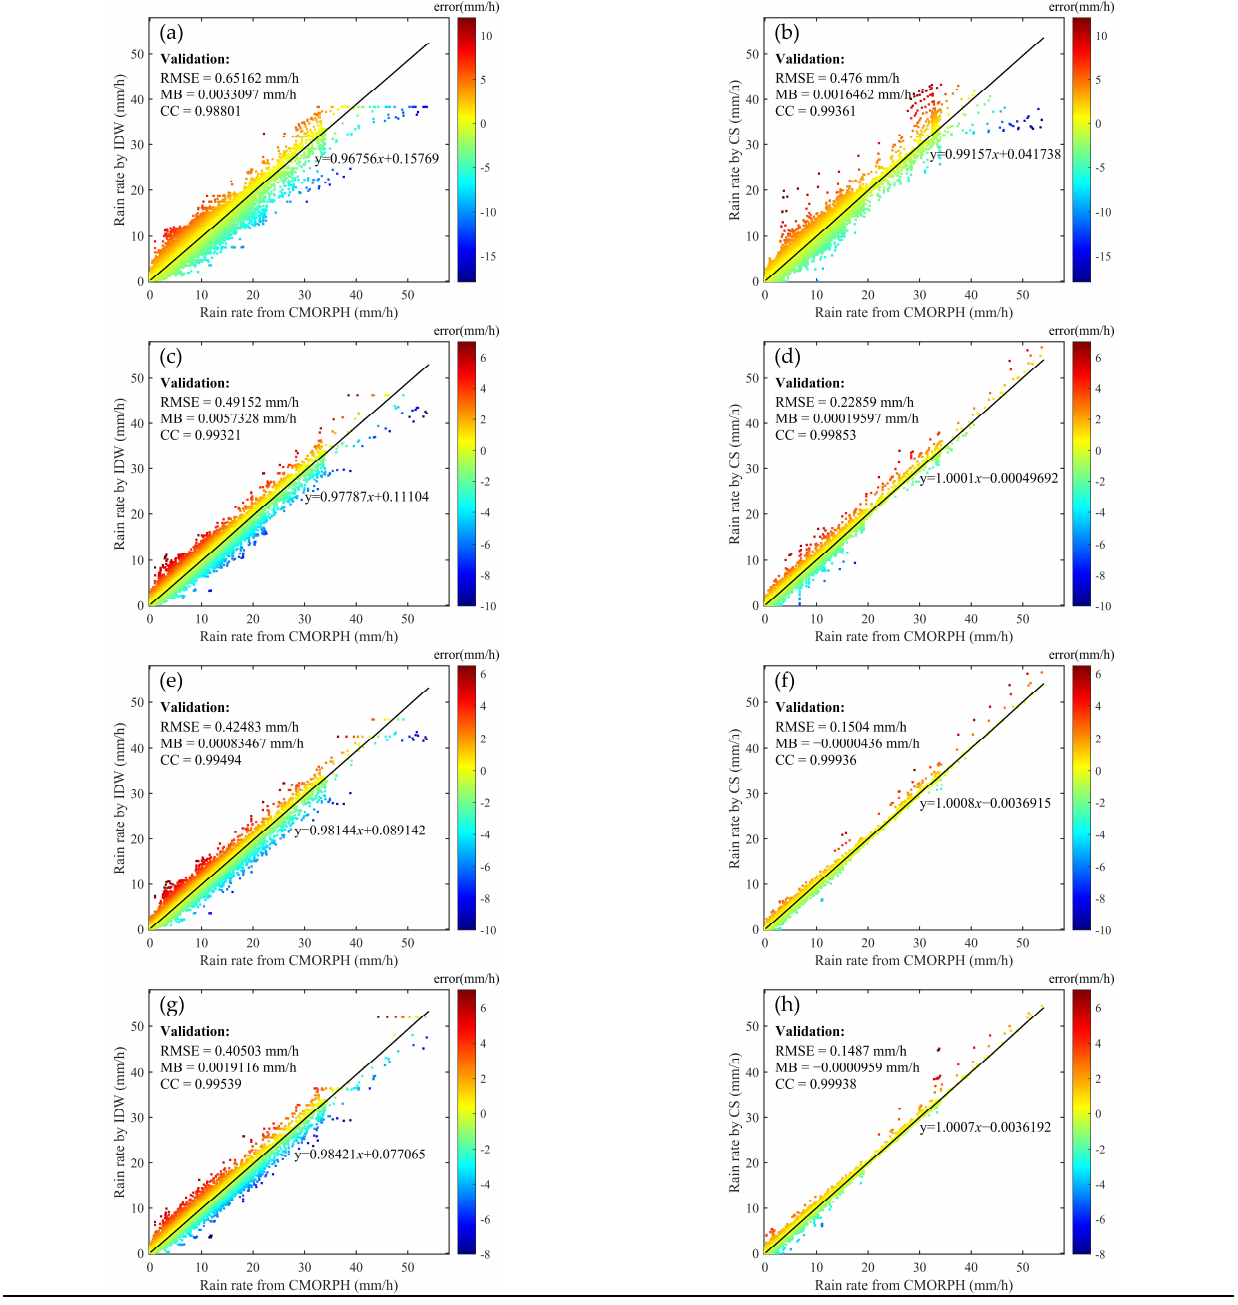
Figure 7. Results of the four designed ESL networks reconstructing the rain rates of rainfall fields. ( a , c , e , g ) are the results of reconstructing the rainfall fields using ESL network 1, ESL network 2, ESL network 3 and ESL network 4 by the IDW algorithm, respectively, and the corresponding ( b , d , f , h ) 3 and ESL network 4 with CS,